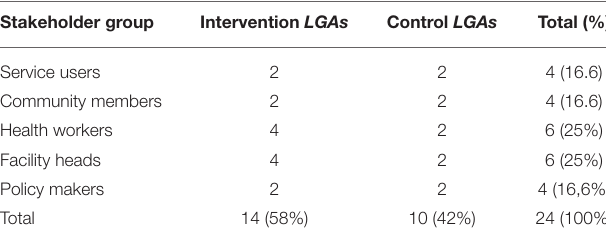
TABLE 2 | Stakeholder groups interviewed for legacy